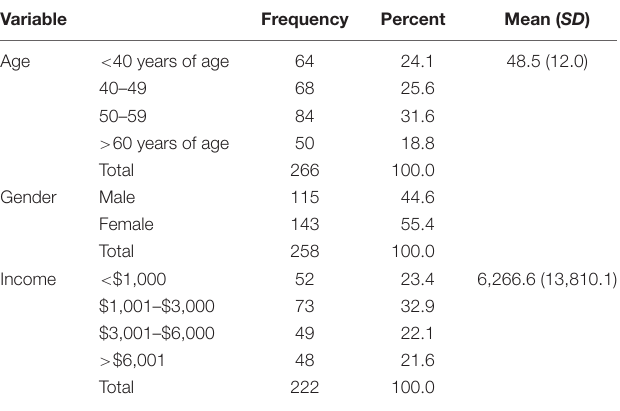
TABLE 1 | Respondents’ socio-demographic